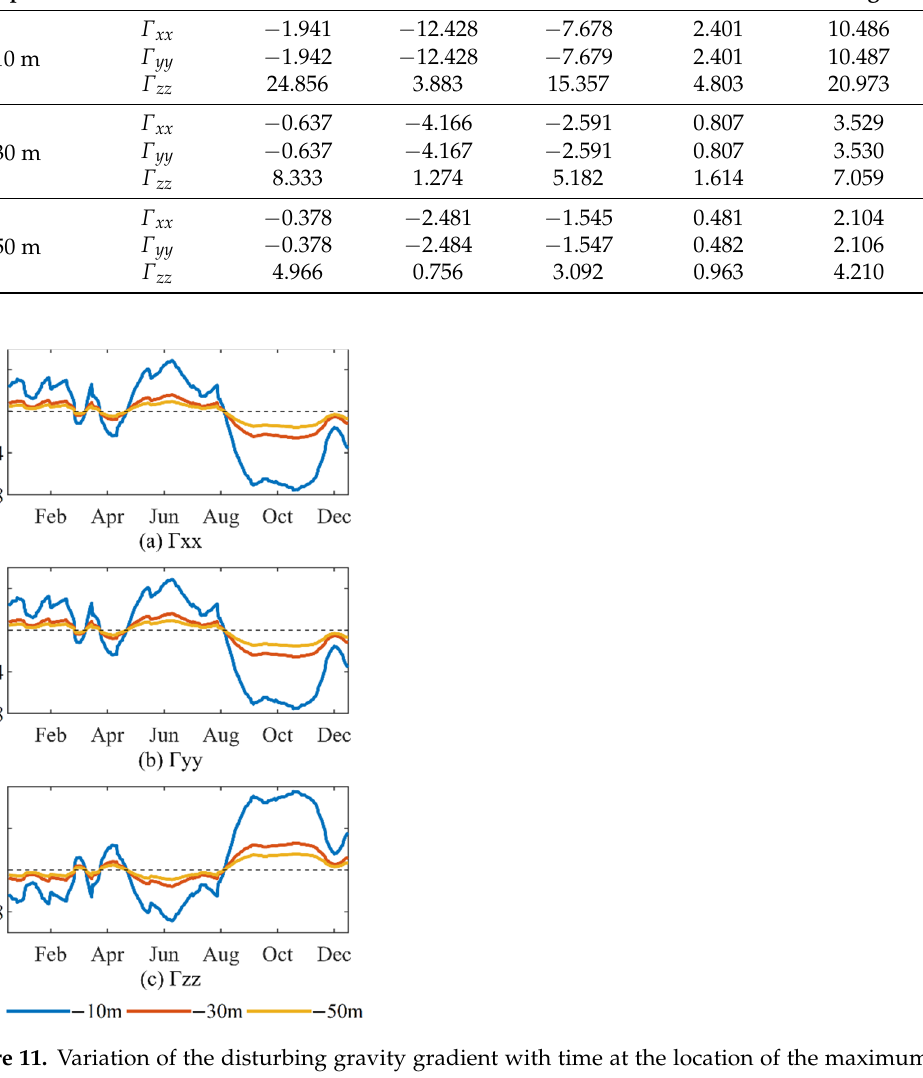
Figure 10. Annual range of the disturbing gravity gradient at 10 m below the mean sea level ( Γ xx and Γ yy are both negative, and the absolute values shown in ( a , b ). Γ zz is positive in ( c ). (unit: E). Table 6. Statistics of the annual range of the disturbing gravity gradient at different depths below the mean sea level (unit: E).